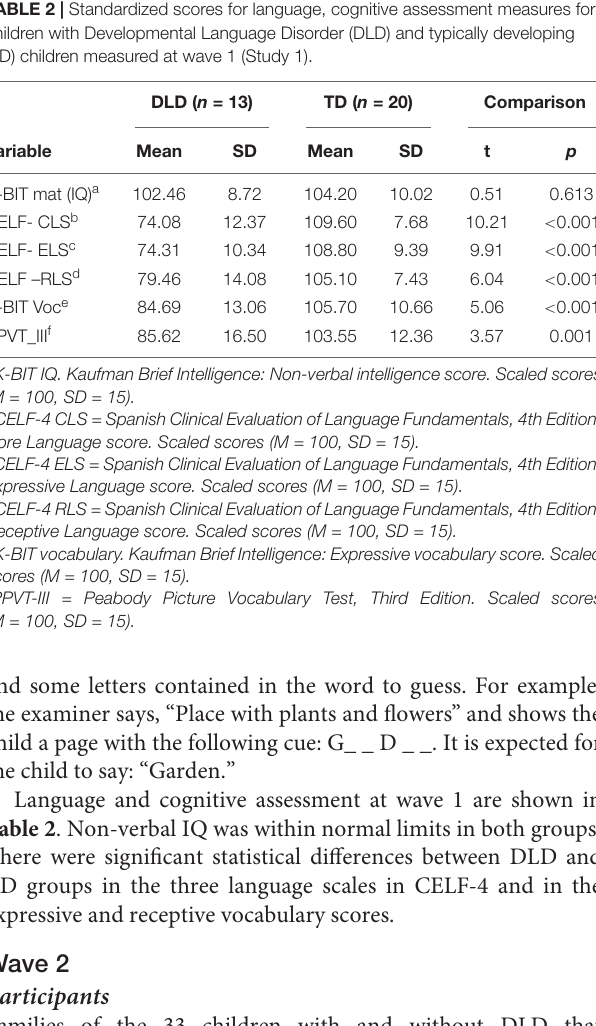
TABLE 1 | Socio-demographic characteristics of the children with Developmental Language Disorder (DLD) and the typically developing (TD) children (Study 1).